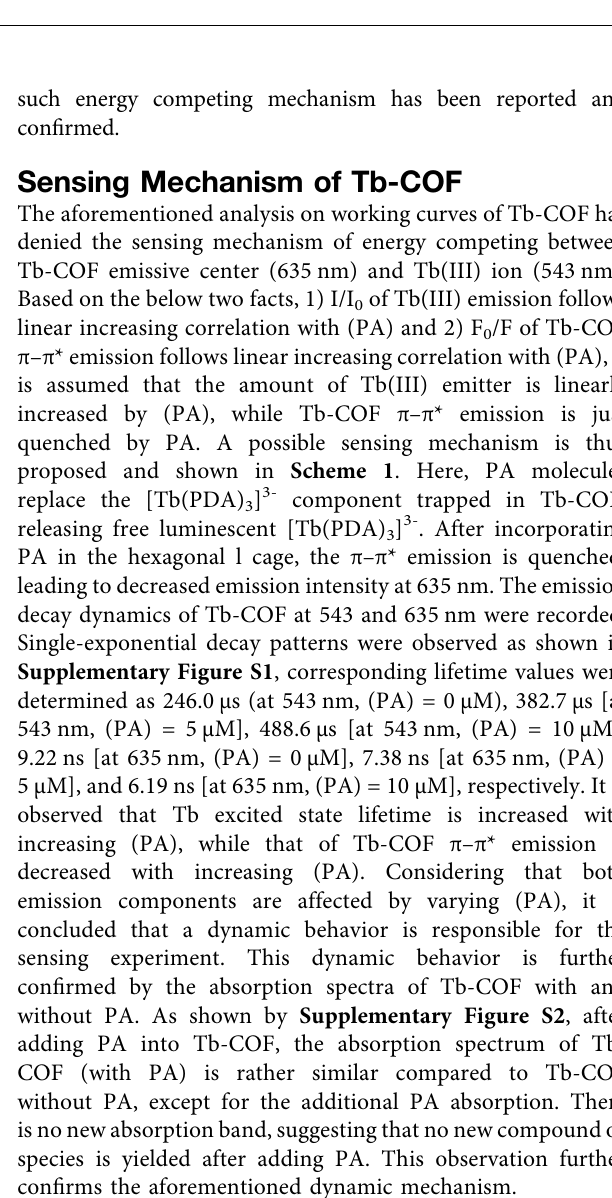
FIGURE 9 | (A) Emission spectra of Tb-COF in the presence of PA and interfering species (10 μ M), 1, PA; 2, K + ; 3, Ca 2+ ; 4, Mg 2+ ; 5, Fe 2+ ; 6, Hg 2+ ; 7, CO 32- ; 8, ACO − ; 9, Cl − ; 10, SO 4 − ; 11, NO 3 − ; 12, p -nitrobenzene; 13, 2,4-dinitrotoluene; 14, 2,4,6-trinitrotoluene; and 15, phosphate anion. Right: corresponding emission intensity ratios of I 543 /I 635 .